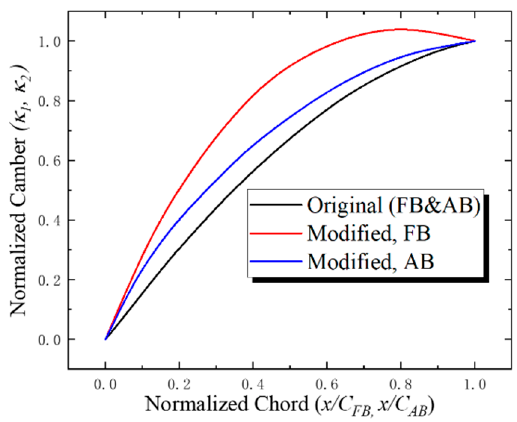
Figure 15. Comparison of camber line between baseline and modified blades.